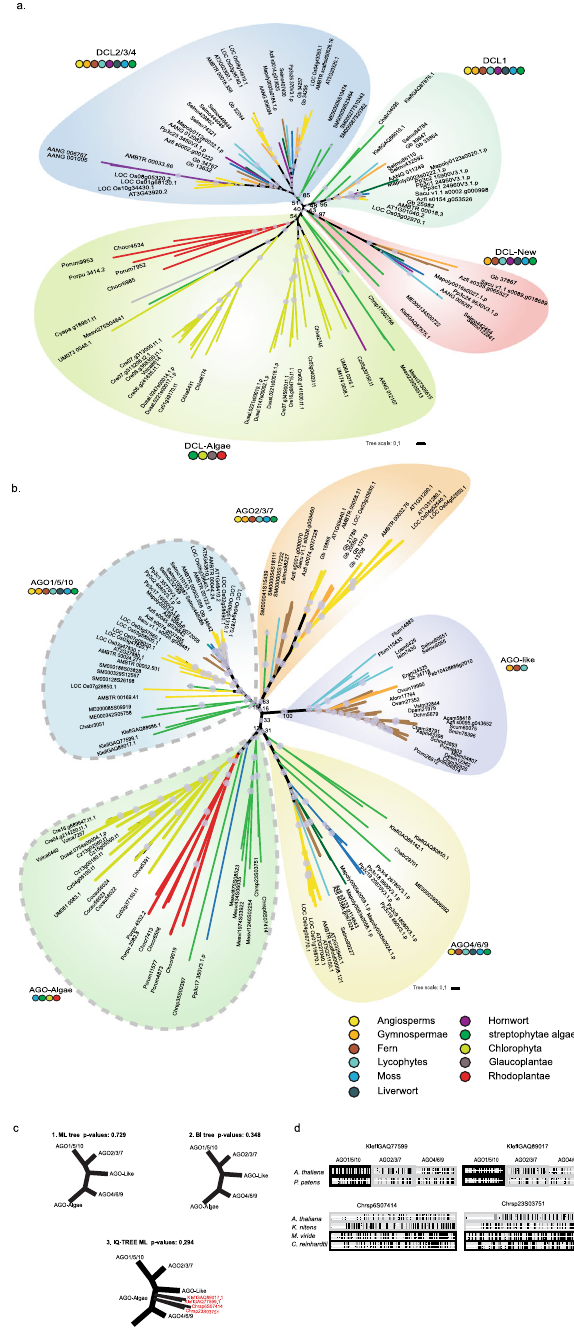
Fig. 2 Phylogenetic trees of AGO and DCL involved in small RNA pathways across the Archaeplastida. a A maximum likelihood tree for DCL genes in selected Archaeplastida species. b A maximum likelihood tree for AGO genes in selected Archaeplastida species. Bootstrap values (500 replicates) are shown on some internal branches. The ID to corresponding species names is listed in Supplementary data S3. c AU test to check the most reliable phylogeny among RAxML, Bayesian and IQ trees (for details see “ Methods ” and Supplementary data S5). d Sequence alignment of the ancestral AGO from K. nitens and C. atmophyticus with AGO from representative